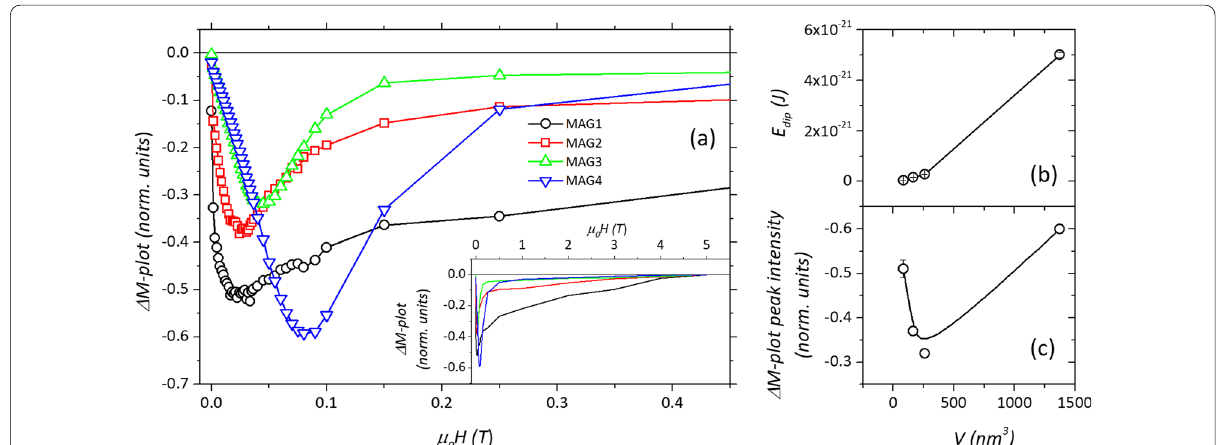
Fig. 4 a Low-field details of the ΔM-plots at 5 K. The full range of the measurements is reported in the inset. b The dipolar interaction energy and c the ΔM-plots peaks’ intensity is plotted as a function of the average particle’s volume, with lines used as a guide to the